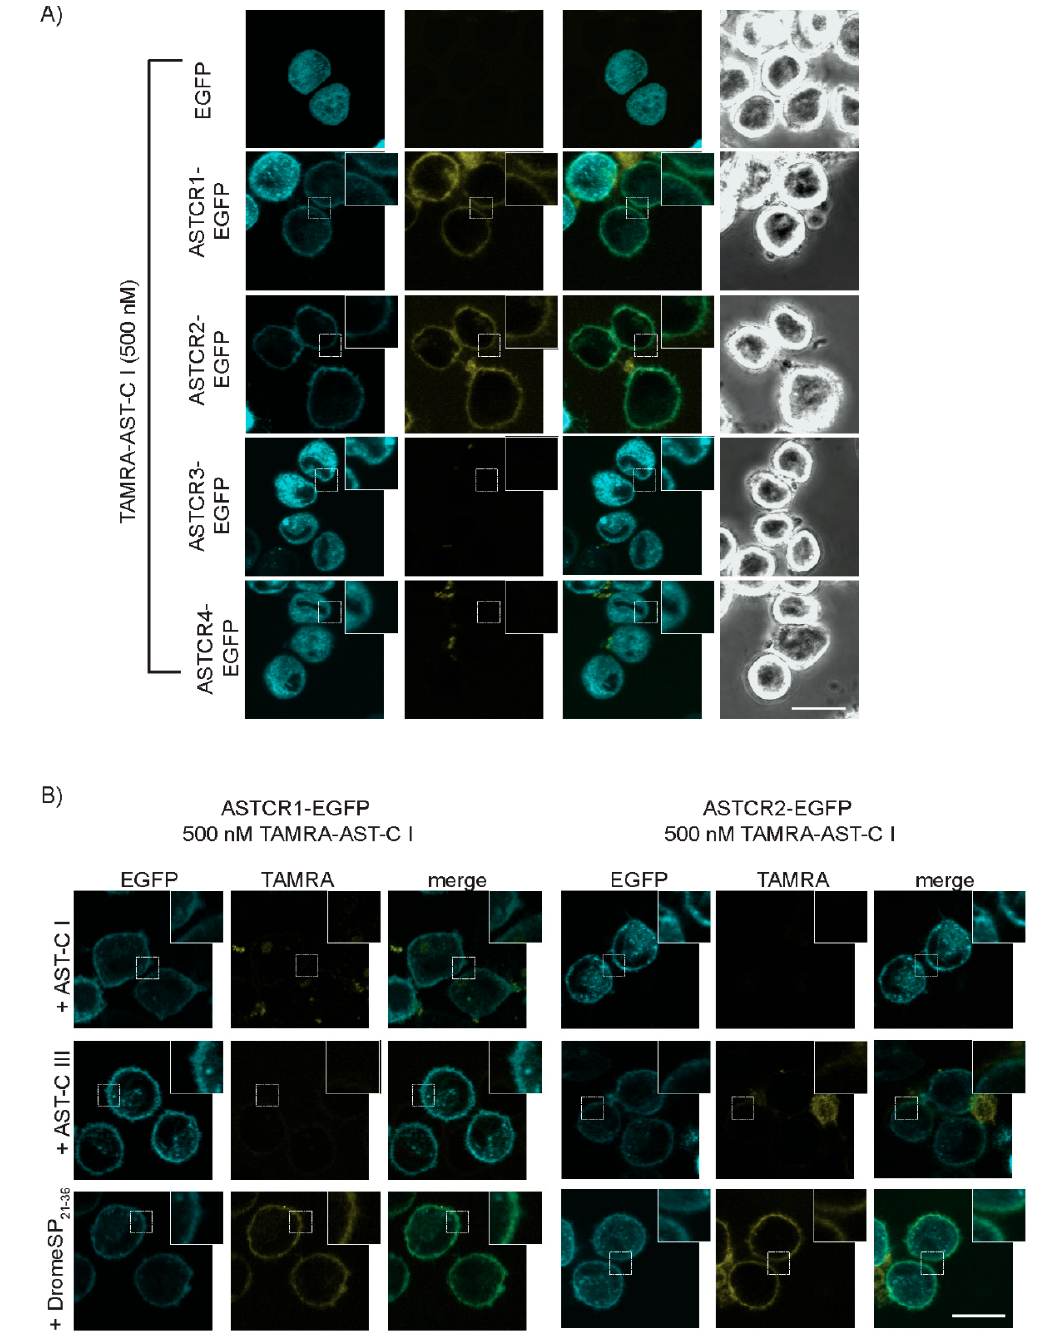
Figure 3. Fluorescent chimeras of select ASTCRs localize at the cell surface and specifically bind AST-C peptides. ( A ) Live cell imaging of Tni insect cells transiently expressing fluorescent EGFP chimeras of the respective H. americanus ASTCRs. Cells were incubated (1 h at 4 ◦ C) with a fluorescent analog of H. americanus AST-C I labeled at the N terminus with carboxytetramethylrhodamine (TAMRA). ( B ) Live cell imaging competitive binding assay of Tni cells transiently expressing fluorescent EGFP chimeras of H. americanus ASTCR1 or 2. Cells were incubated as before, but also in the presence of 5 µM unlabeled H. americanus AST-C I, AST-C III, or a D. melanogaster sex peptide fragment corresponding to residues 21–36 (DromeSP21–36). Insets: magnification of plasma membrane fluorescence. All cells were imaged in the presence of 0.45 M sucrose (inhibition of clathrin-mediated receptor internalization) using filter sets for EGFP (Em = 489 nm/Ex = 510 nm) and TRITC (Em = 546 nm/Ex = 579 nm) with EGFP and TAMRA fluorescence pseudo-colored cyan and yellow, respectively. Co-localization of the two signals, depicted in green in the merged images, supports receptor-dependent binding. Images are representative of cells encompassing multiple independent transfections. Scale bar = 20 µm.